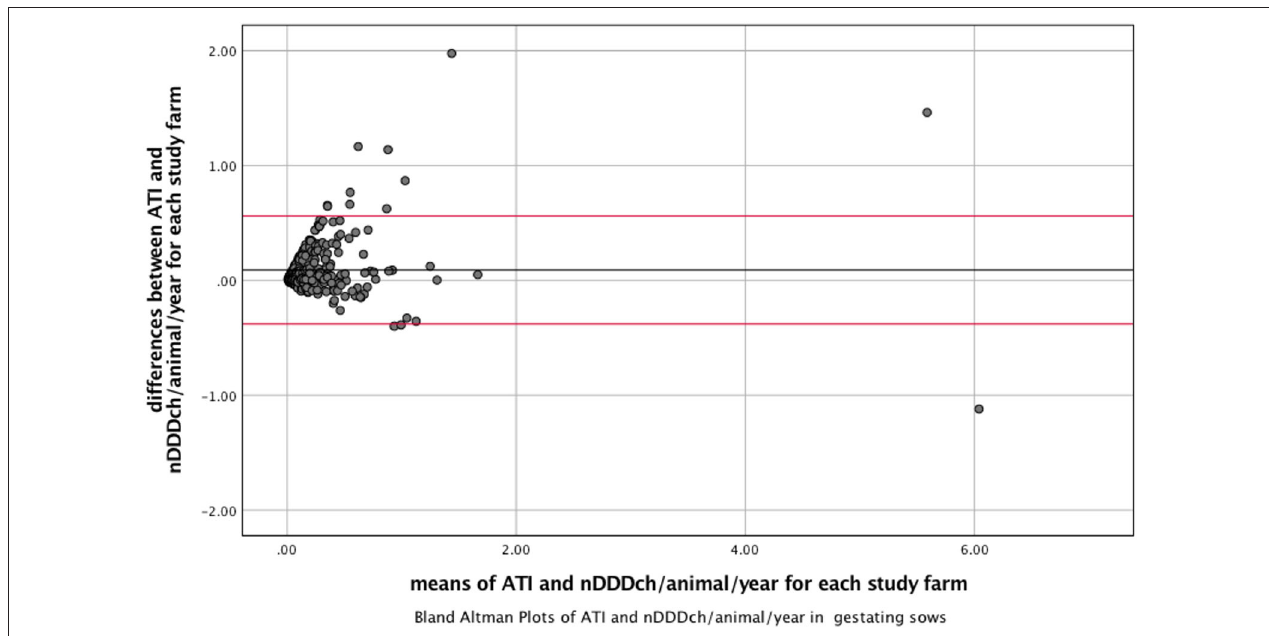
FIGURE 4 | Bland-Altman Plots visualizing interrater reliability of the indicator Animal Treatment Index (ATI) and number of DDDch (nDDDch)/animal/year for 319 farms housing gestating sows. X-Axis: mean of ATI and nDDDch/animal/year; Y-axis: differences between ATI and nDDDch/animal/year. Red lines: ± 1.96 * standard deviation of the datasets calculated from the differences between ATI and